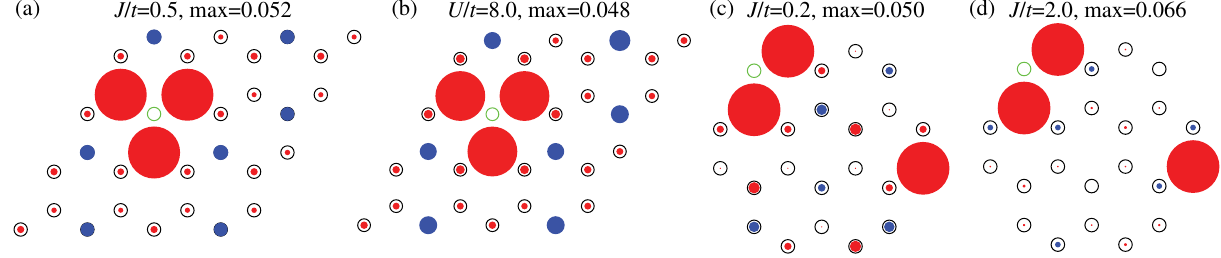
i Þ S j Þi measurement. Blue is positive, red negative, and disk radius is proportional to FIG. 11. Spin-spin correlation function h S z ð z ð amplitude. Site i is fixed at green circle, while every bond i , j is averaged over translations and rotations to increase the number of sampled observable values in MC runs and thereby reduce statistical error. “ max ” labels absolute amplitude of largest shown disk. The measurement on 32-site sample uses the DMRG ground state projected into sector with center-of-mass momentum Γ and C 6 rotation eigenvalue exp ð − i π = 3 Þ : (a) t - J model, J=t ¼ 0 . 5 , (b) Hubbard model, U=t ¼ 8 . The spin-spin correlation is longer ranged and consistent with tetrahedral pattern throughout CSDWor SCCL phase. On 24-site sample, the t - J model DMRG ground state is projected into sector with C 6 eigenvalue exp ð − i 2 π = 3 Þ . (c) Same correlation behavior is found deep in small- J regime of 24-site sample, while (d) spin pattern is lost in large- J regime, even as short-range correlations grow.